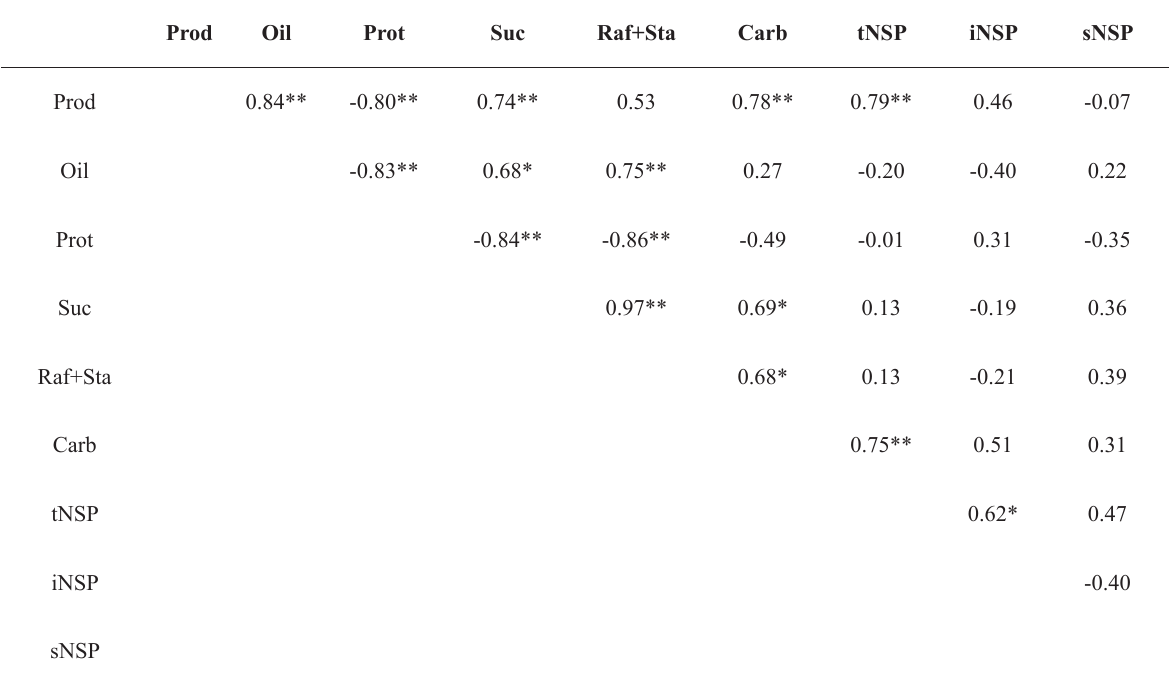
Estimated pairwise Pearson correlation coefficients for: productivity (Prod, Kg.ha -1 ) and contents (g.100 g protein (Prot), sucrose (Suc), raffinose + stachyose (Raf+Sta), total carbohydrates (Carb), total NSP (tNSP), insoluble